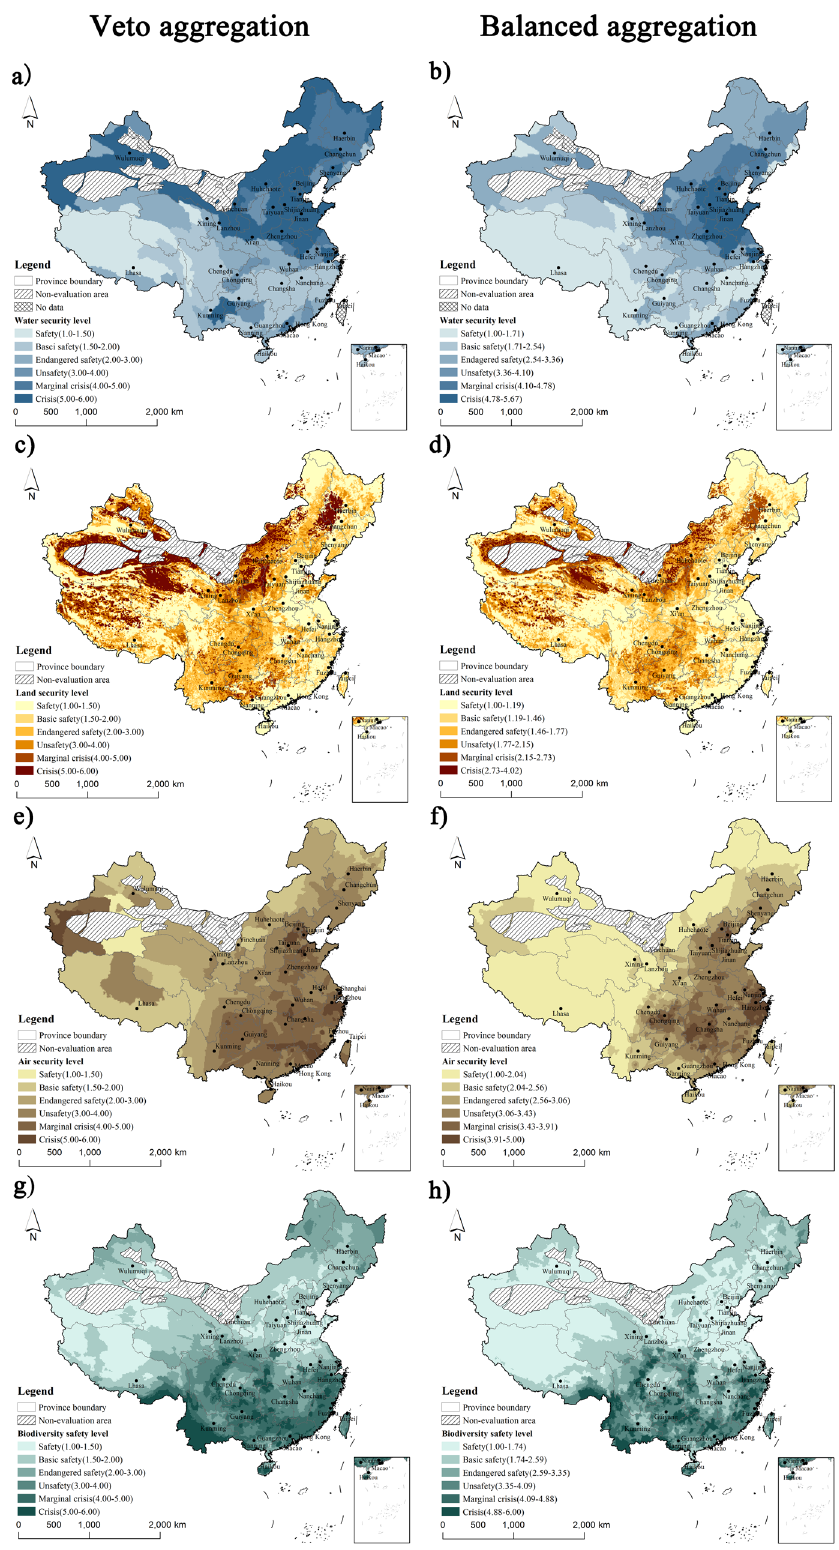
Figure 1. Spatial distribution of veto aggregation result including ( a ) water security in 2010; ( c ) land security in 2010; ( e ) air security in around 2010; ( g ) biodiversity security in around 2010; and balanced aggregation result including ( b ) water security in 2010; ( d ) land security in 2010; ( f ) air security in around 2010; ( h ) biodiversity security in around 2010. Maps were generated by ArcGIS version 10.1.0 (http://www.esri.com/software/ arcgis). Note: Non-evaluation areas were at the extreme of degradation and cannot support human survival and